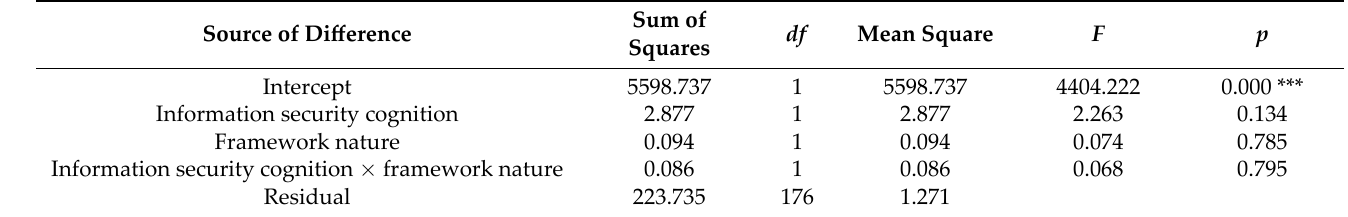
Table 13. Results of Two‑Way ANOVA.